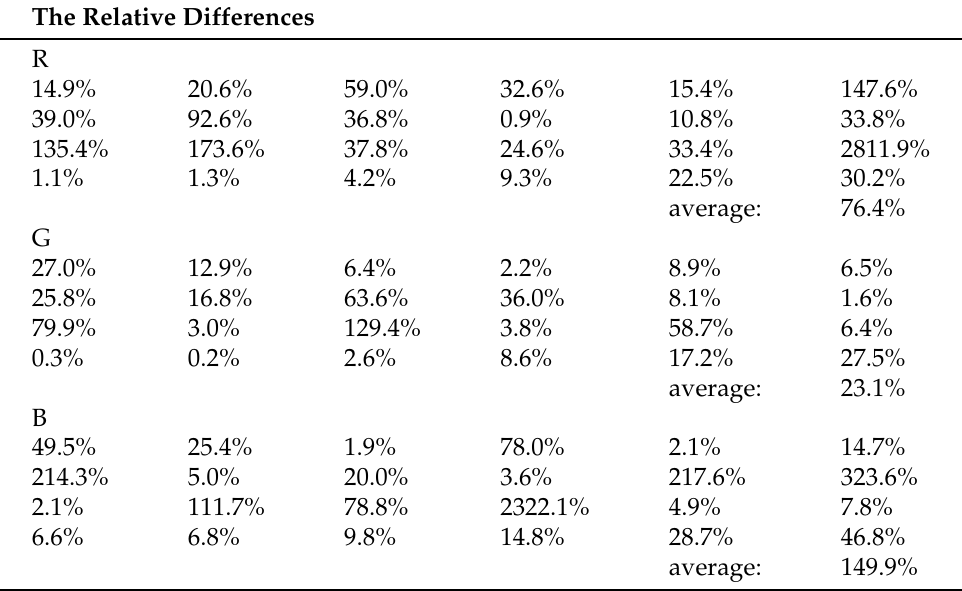
Table A3. The absolute values of relative differences between the linear TLS and spectroradiometer measurements for each channel R, G, and